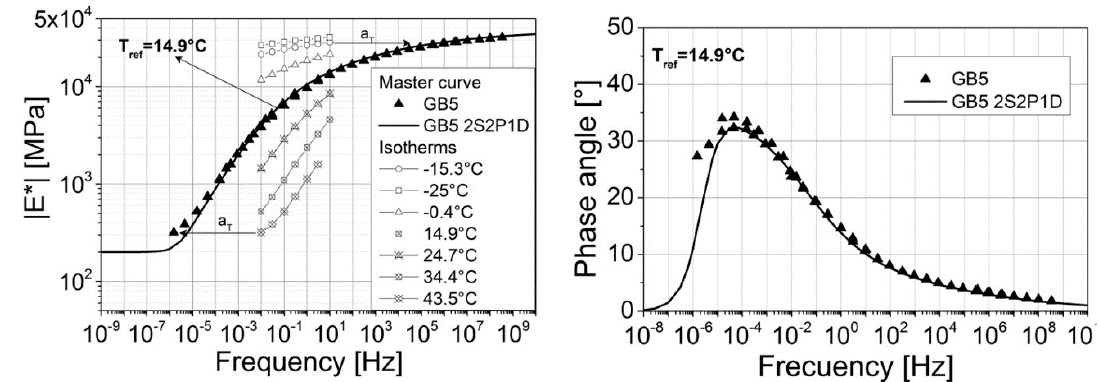
Figure 10. Master curves of the complex modulus (left) and phase angle (left) for GB5  .